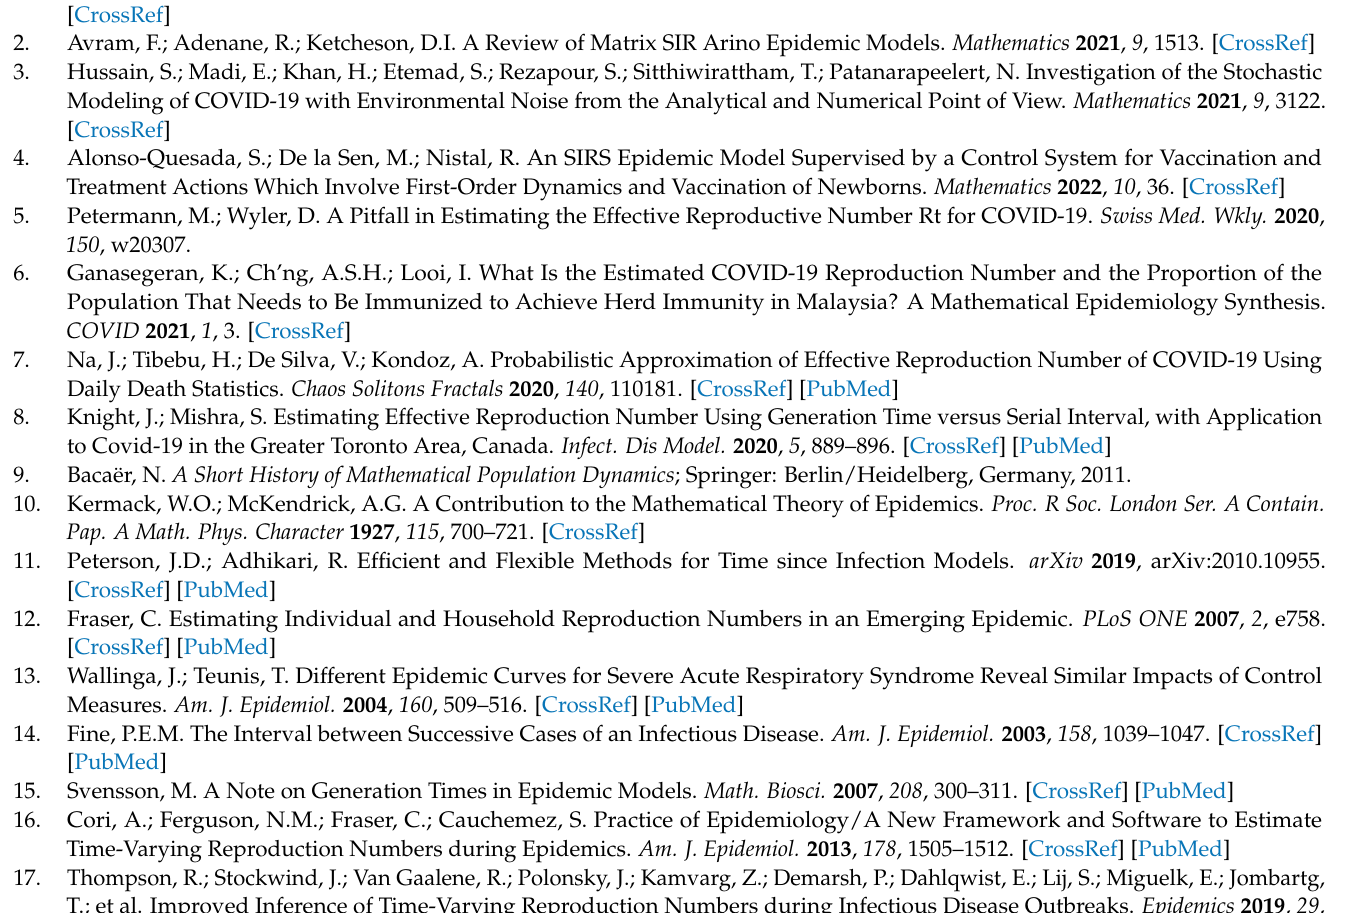
Figure A5. Superposition of 95% confidence intervals calculated with the exact probability density function and a subrogated Gamma density function.